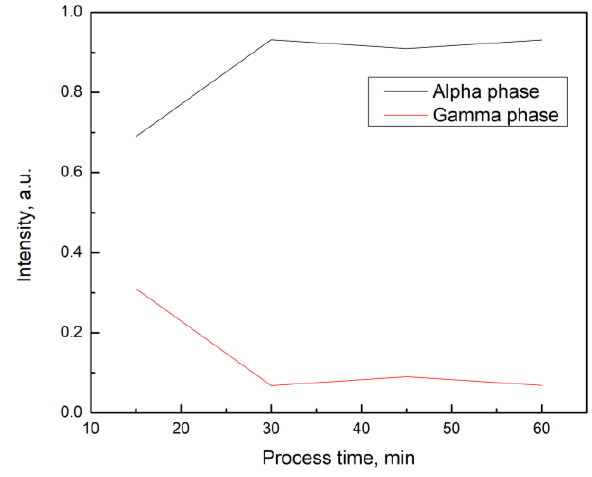
Figure 3. α -Al 2 O 3 and γ -Al 2 O 3 phase concentrations as derived from XRD measurements for samples with different PEO process duration.